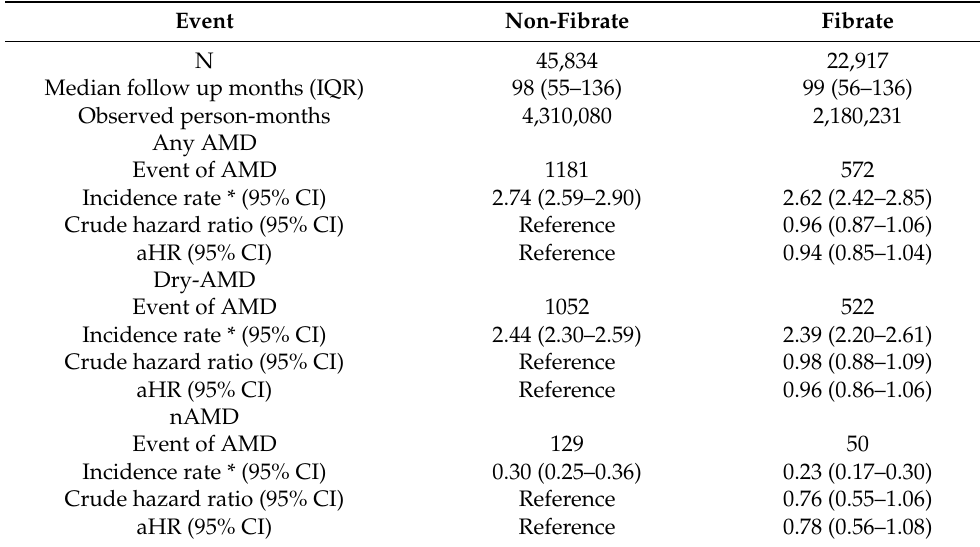
Table 3. Study event in study groups.